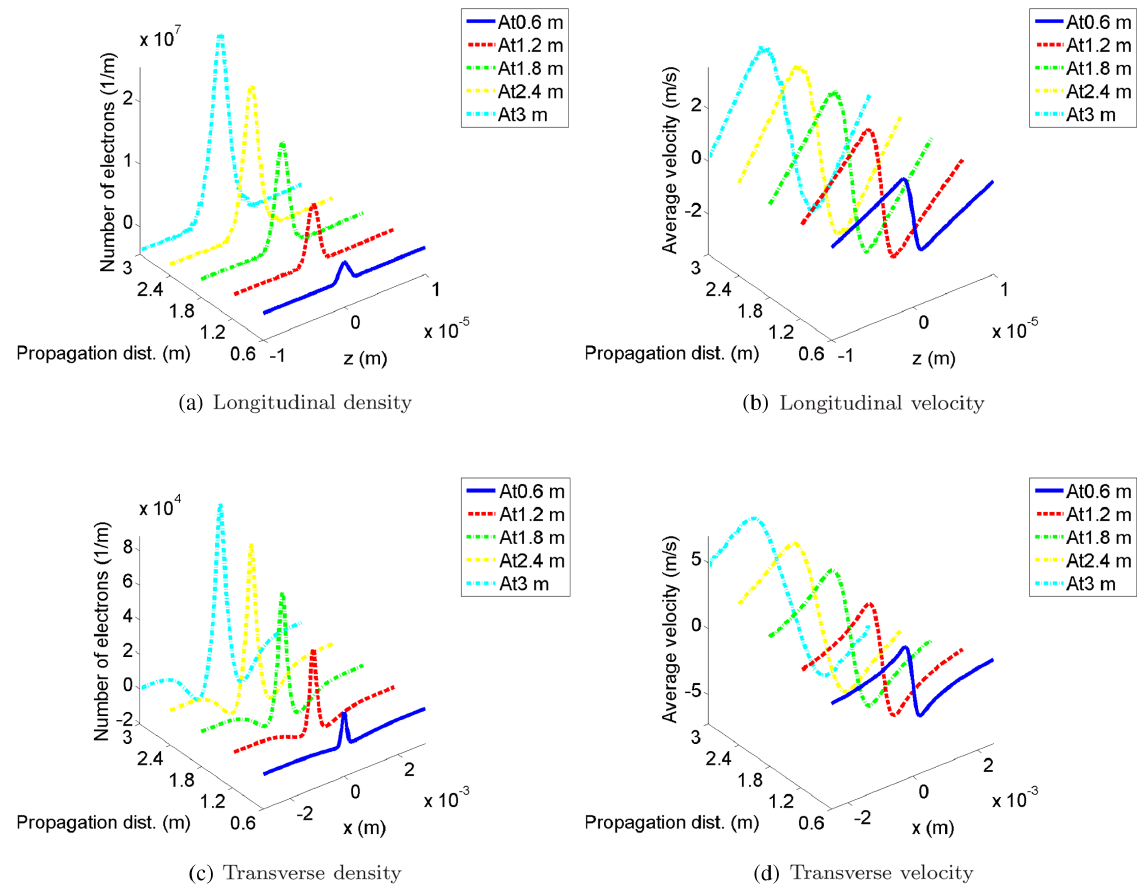
FIG. 5. Longitudinal and transverse density and velocity modulation by reference energy ion in the center of the Gaussian electron beam in linear focusing field after 0.6 m (blue, solid line), 1.2 m (red, dash line), 1.8 m (green, dash-dot line), 2.4 m (yellow, dash-dot line), and 3 m (cyan, dash-dot line) of copropagation with